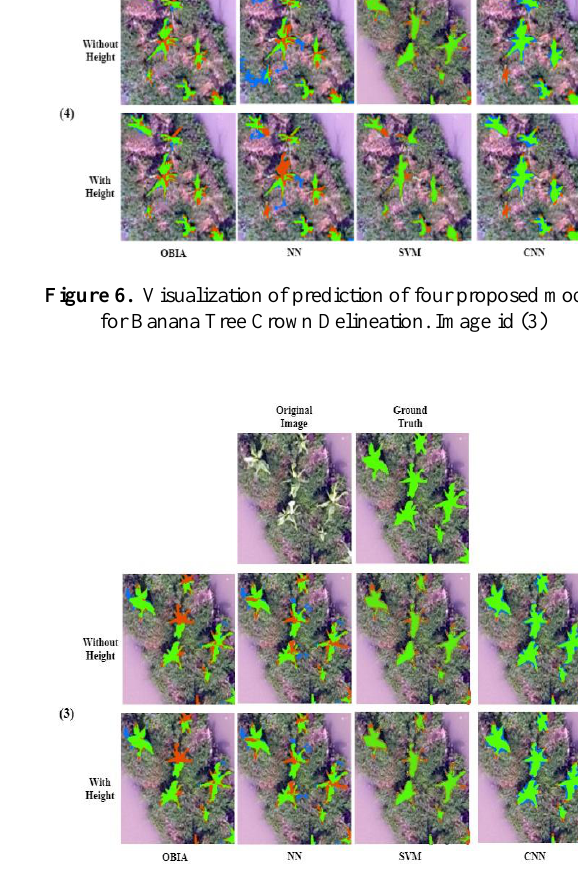
Figure 7 . Visualization of prediction of four proposed model for Banana Tree Crown Delineation. Image id